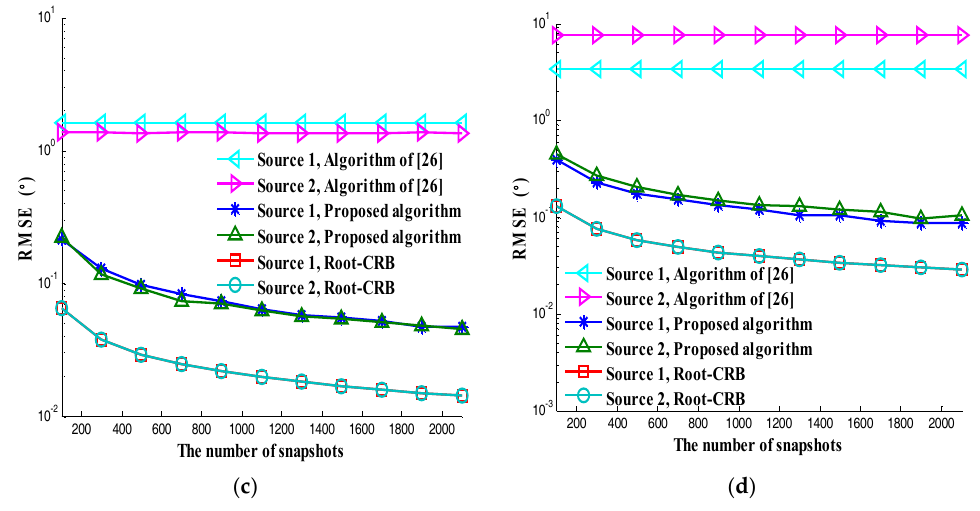
Figure 7. RMSE versus number of snapshots: ( a ) Elevation; ( b ) Azimuth; ( c ) Auxiliary polarization angle; ( d ) Polarization phase difference.